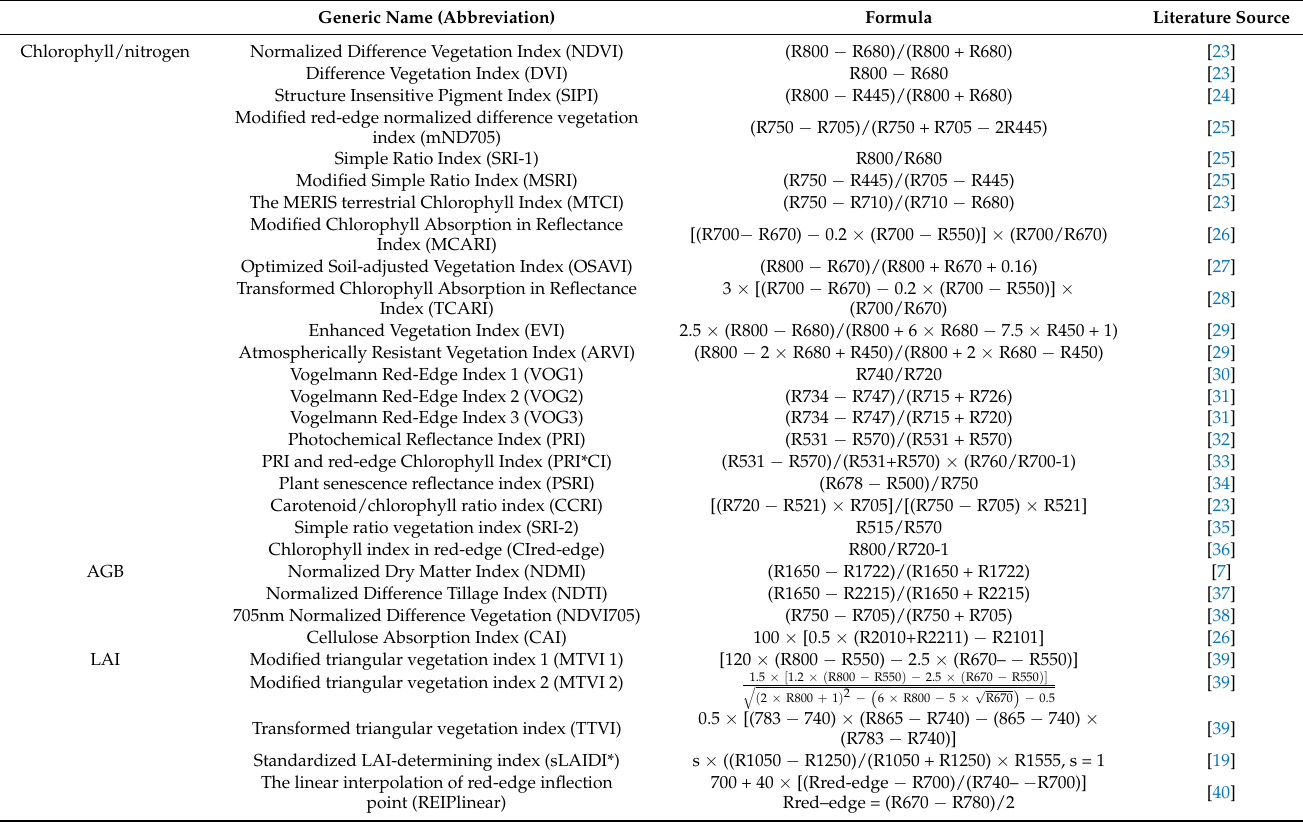
Table 4. List of hyperspectral vegetation indexes used in this